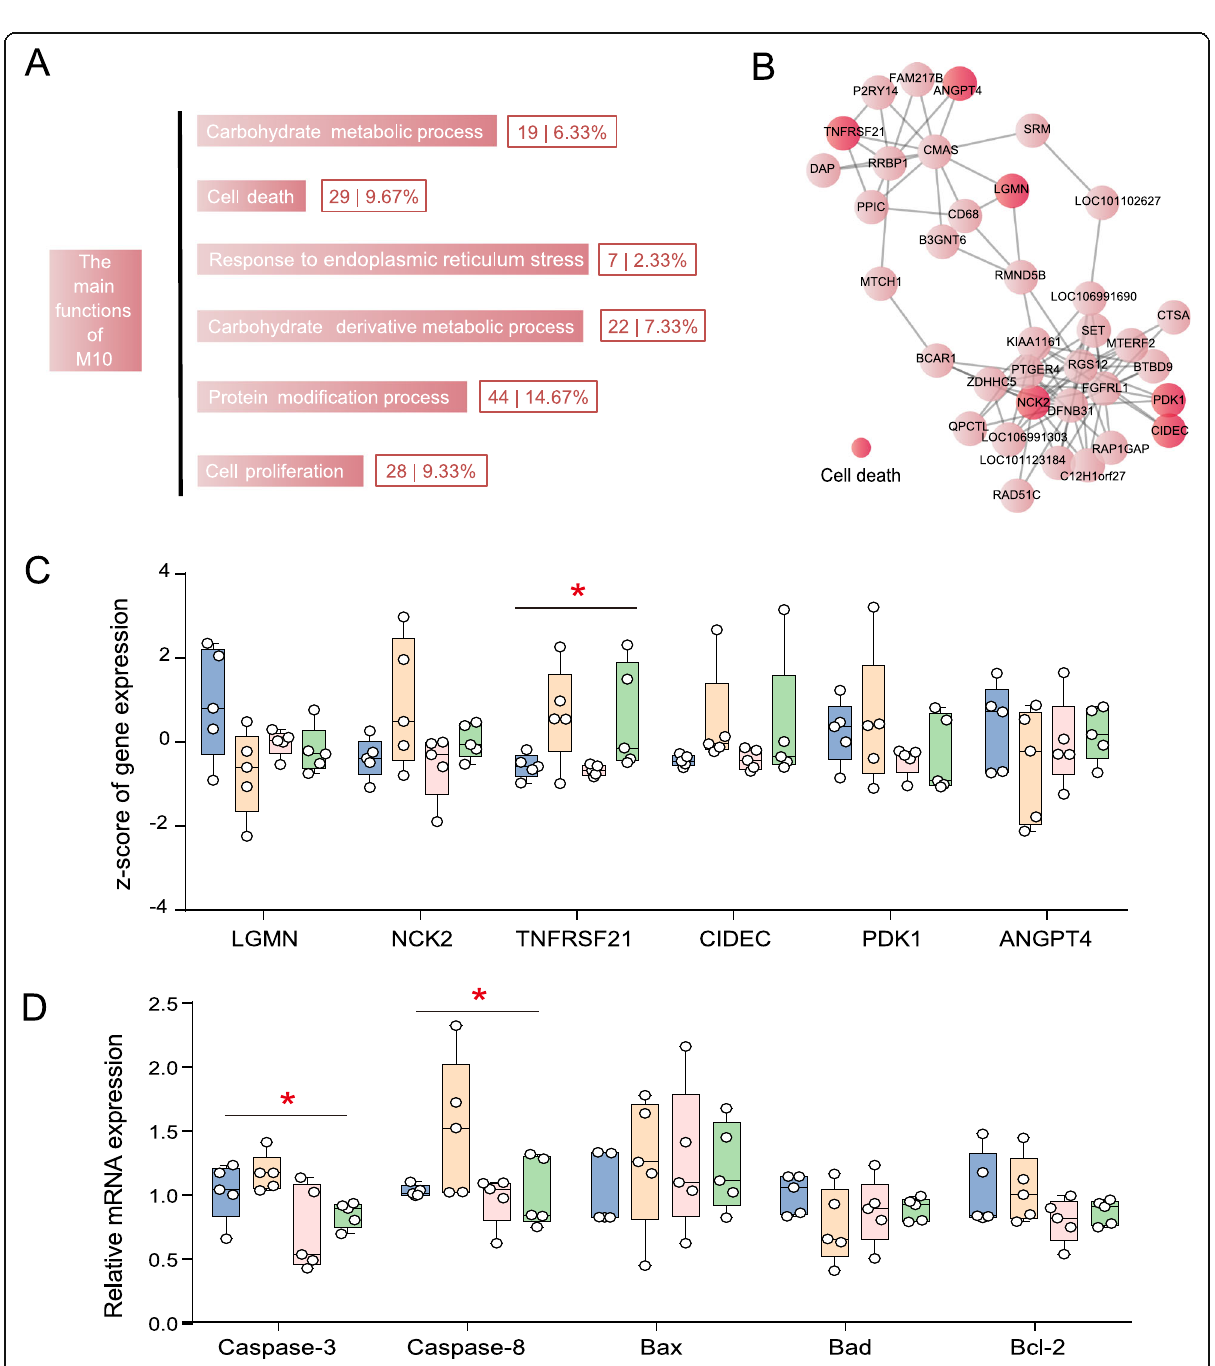
Fig. 4 a The significant GO terms ( p < 0.05) in biological processes of the M10. b The network of hub genes in the M10. The six genes in red were enriched in a cell apoptotic process. c The z-sore of six gene expressions, including LGMN , NCK2 , INFRSF21 , CIDEC , PDK1 , and ANGPT4 , are shown among the four groups based on transcriptome analysis. * p < 0.05. d The relative mRNA abundance of genes related to cell apoptosis by qRT-PCR in the colon of hay-fed (CON) and HG-diet-fed sheep (HG7 – 28). Values are means ( n = 5), with their standard errors represented by vertical